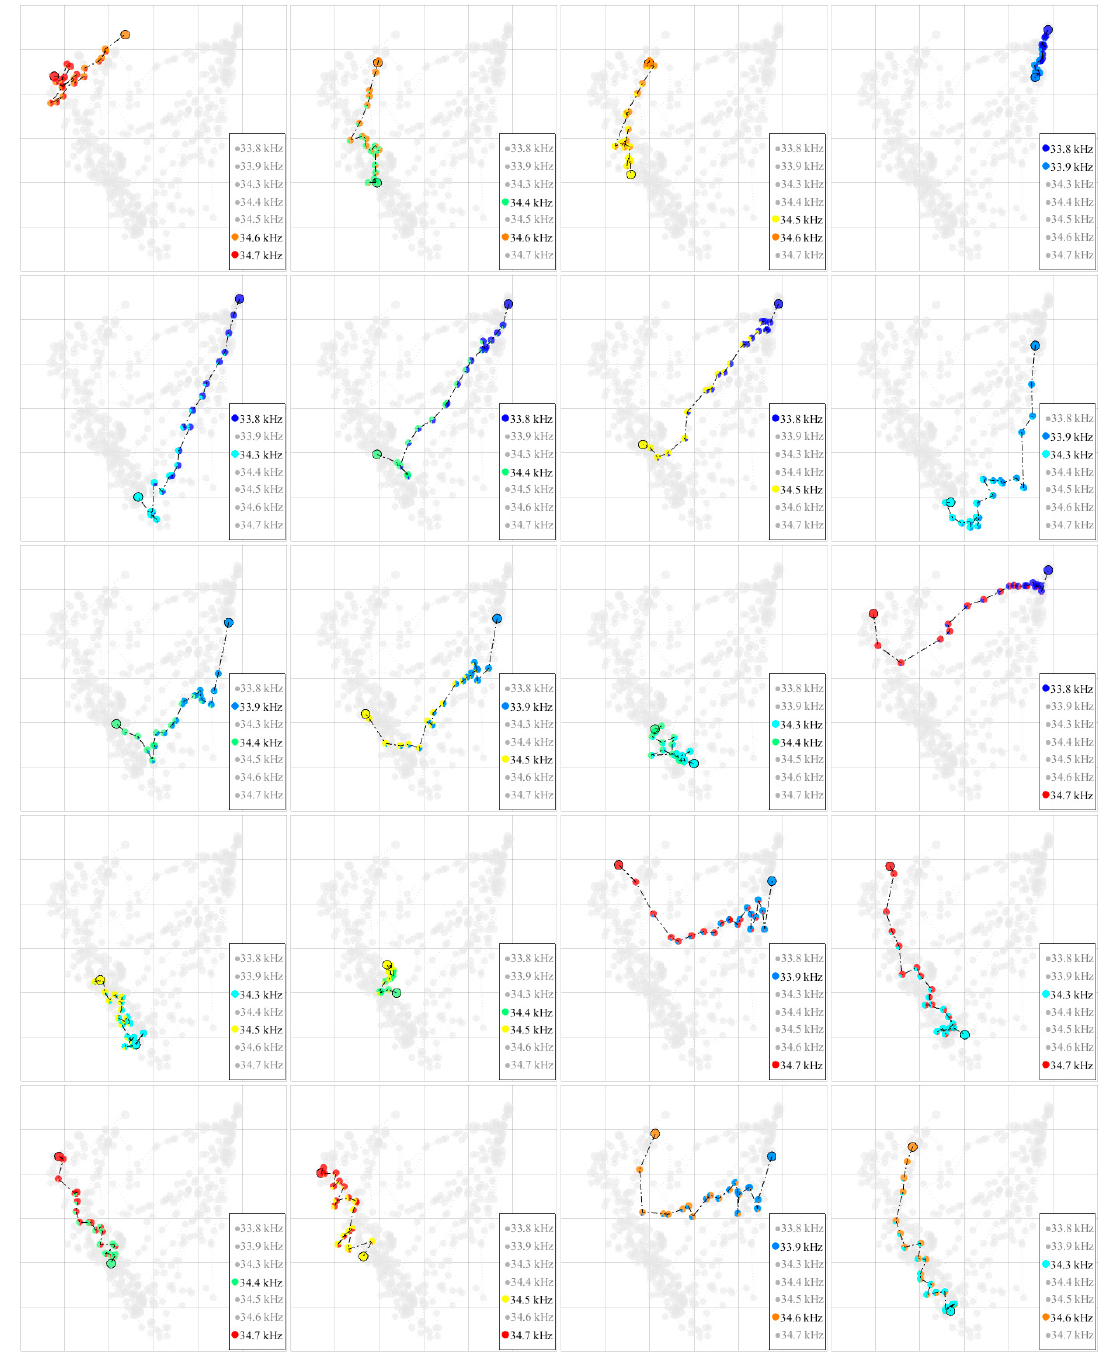
Figure 7. Levitation positions of composite signals for the remaining 20 pairs of combinations from the seven frequencies, excluding one combination of 33.8 and 34.6 kHz.